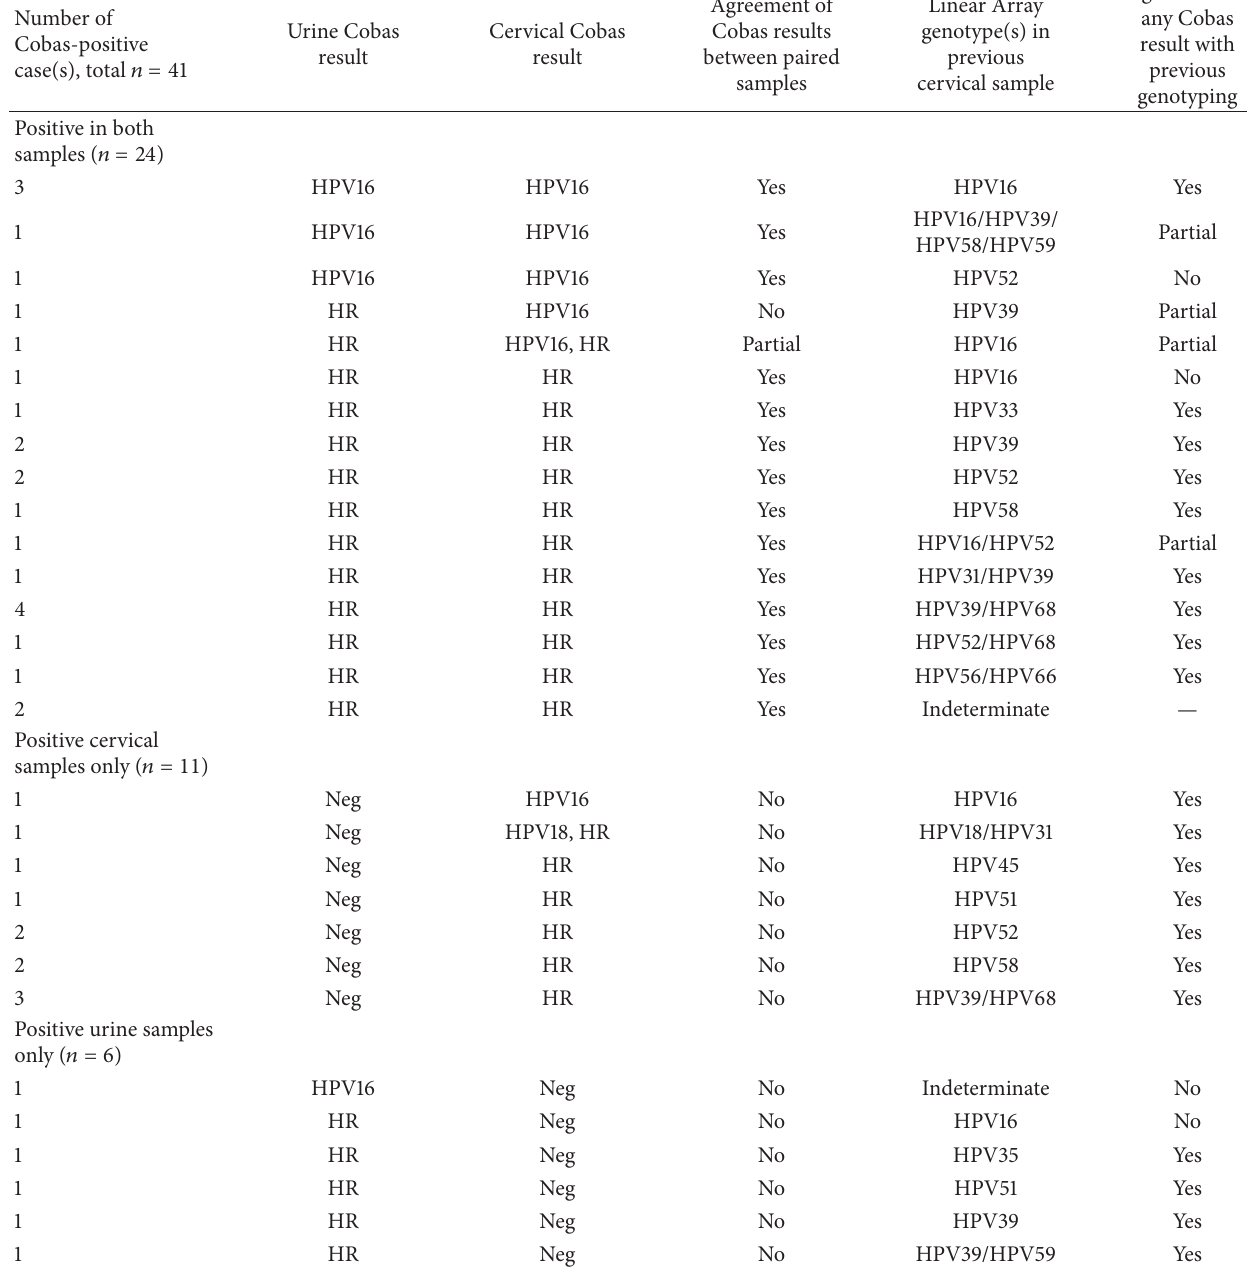
Table 2: Results of Cobas HPV Test and previous genotyping in 41 women with HPV-positive urine and/or cervical samples. Number